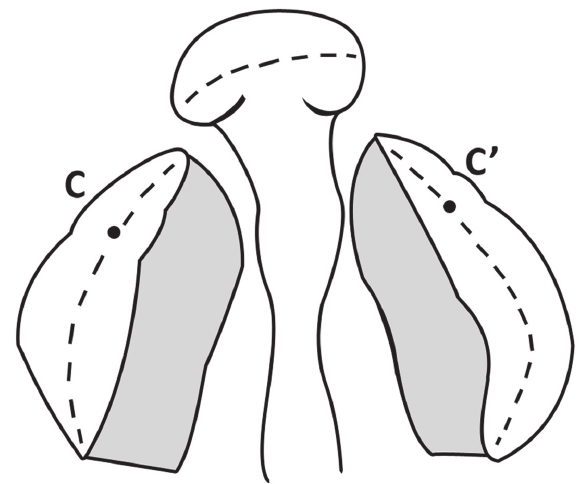
Figure 6- Canine landmarks in unilateral cleft lip and palate patients Figure 7- Canine landmarks in bilateral cleft lip and palate